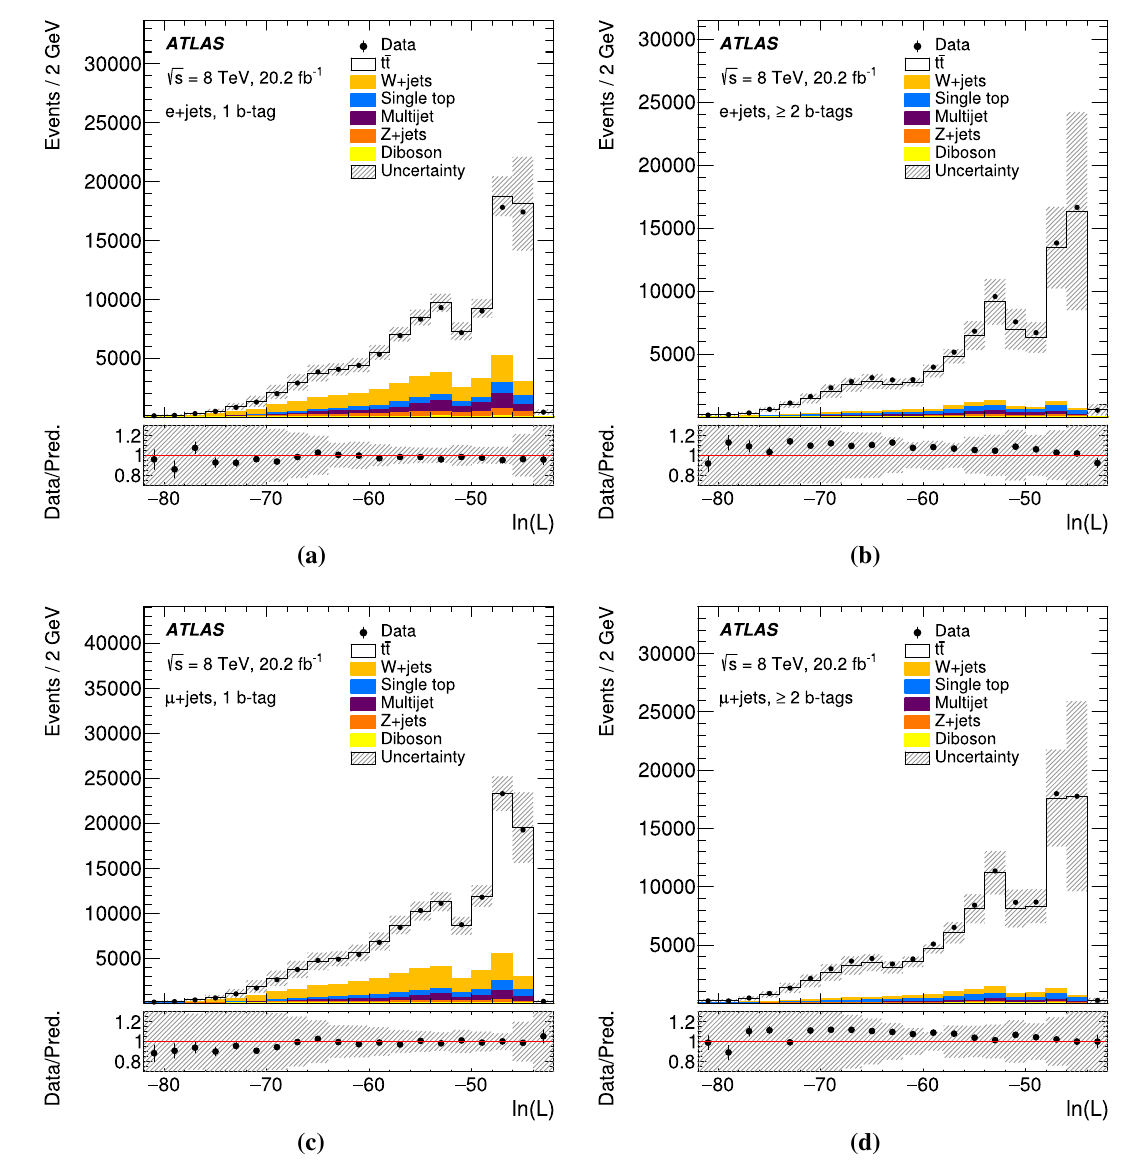
Fig. 3 Distributions of the logarithm of the likelihood obtained from the event reconstruction algorithm for the selected a , b electron+jets and c , d muon+jets events with a , c exactly one and b , d at least two b -tagged jets. The hatched bands show the normalisation uncertainty in